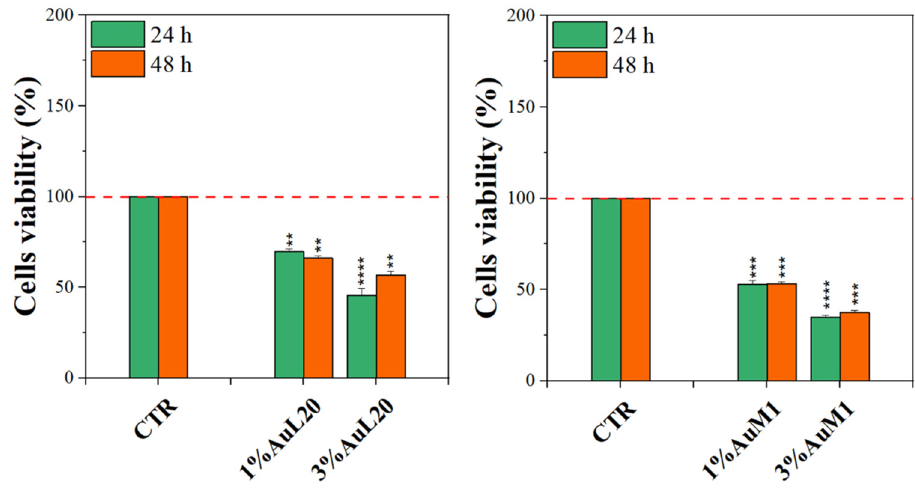
Figure 7. MTT assay on MeWo cells when cultured on 1% and 3% functionalized PCL membrane surface for 24 h and 48 h. The experiments were analyzed by two-tailed Student’s t-test, ** p < 0.01, *** p < 0.001 and **** p ≤ 0.0001 .